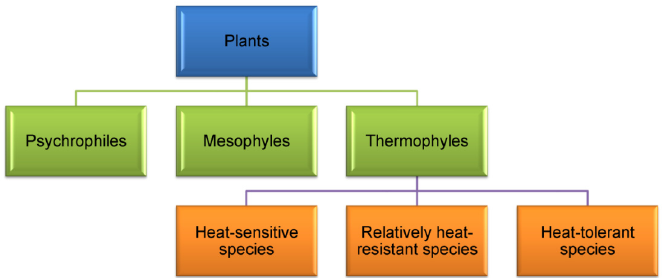
Figure 3. Classification of plants on the basis of their heat tolerance.